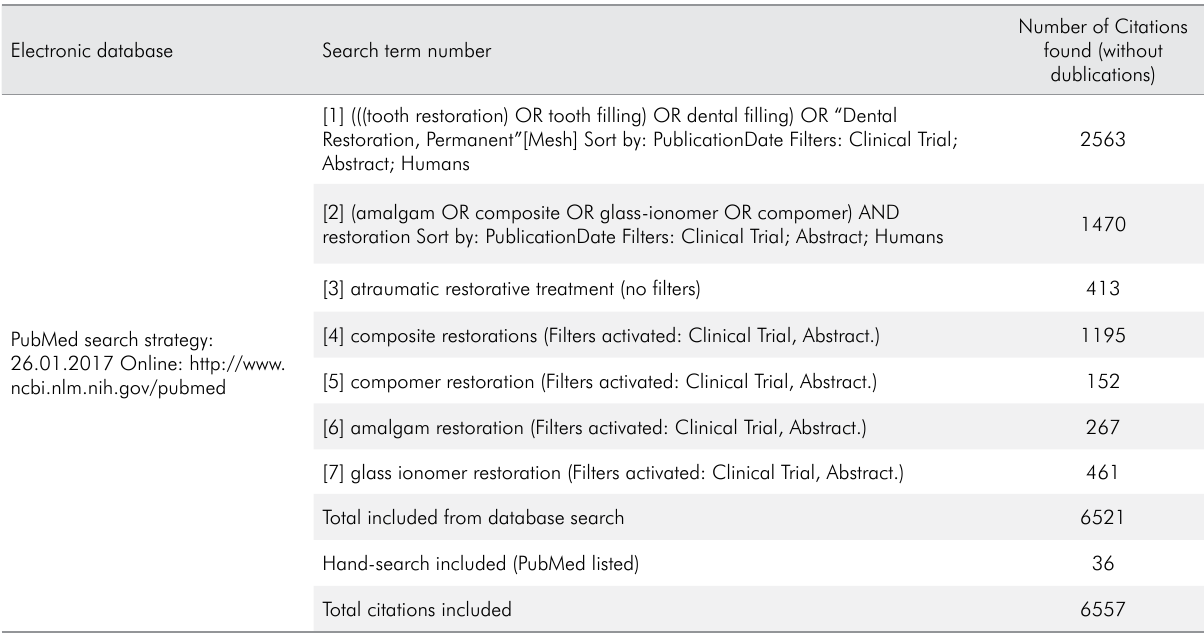
Table. Search strategy: electronic database search. Electronic